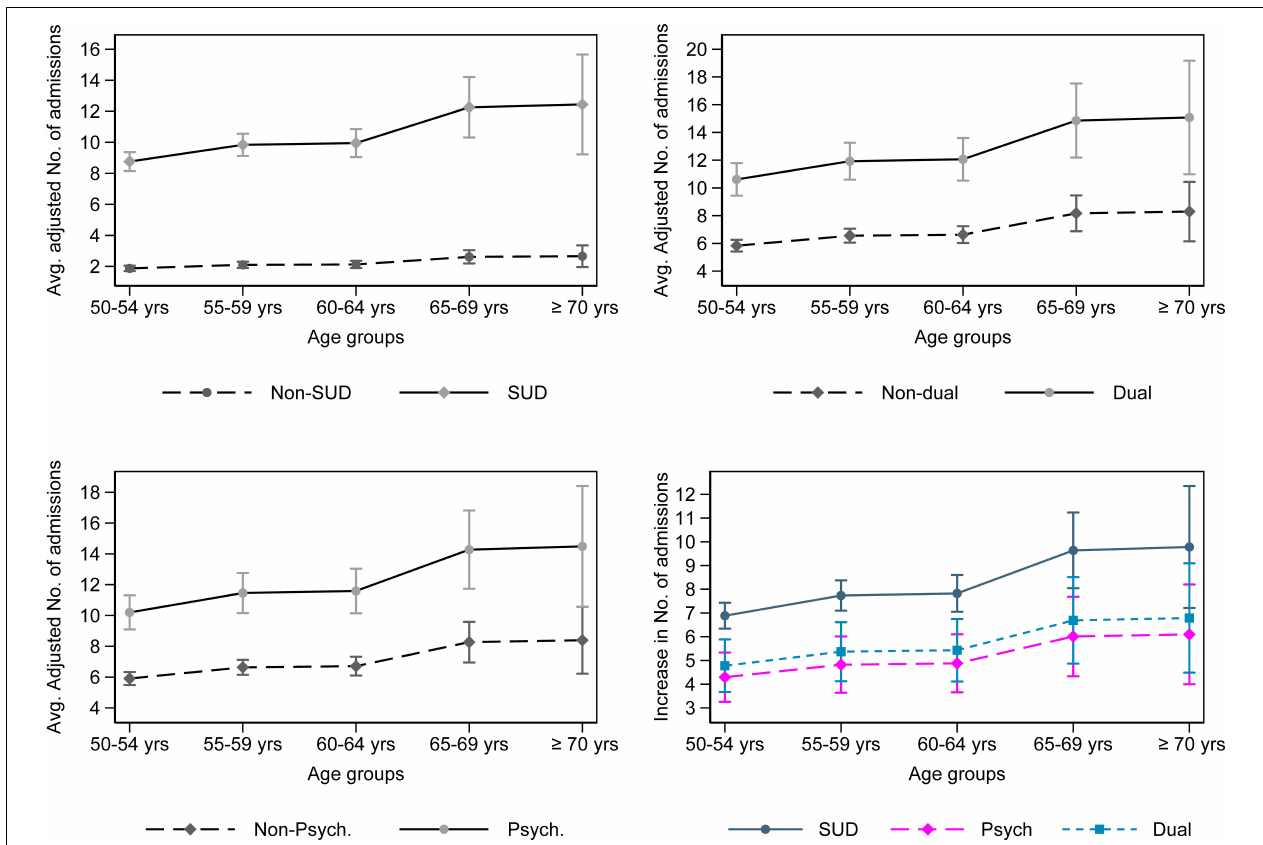
FIGURE 2 | Adjusted predictions and partial effects of SUD, dual and psychiatric diagnoses across five age groups for hospital admission rate. The figure on the bottom right depicts the partial effects for the diagnoses vs. not having the respective